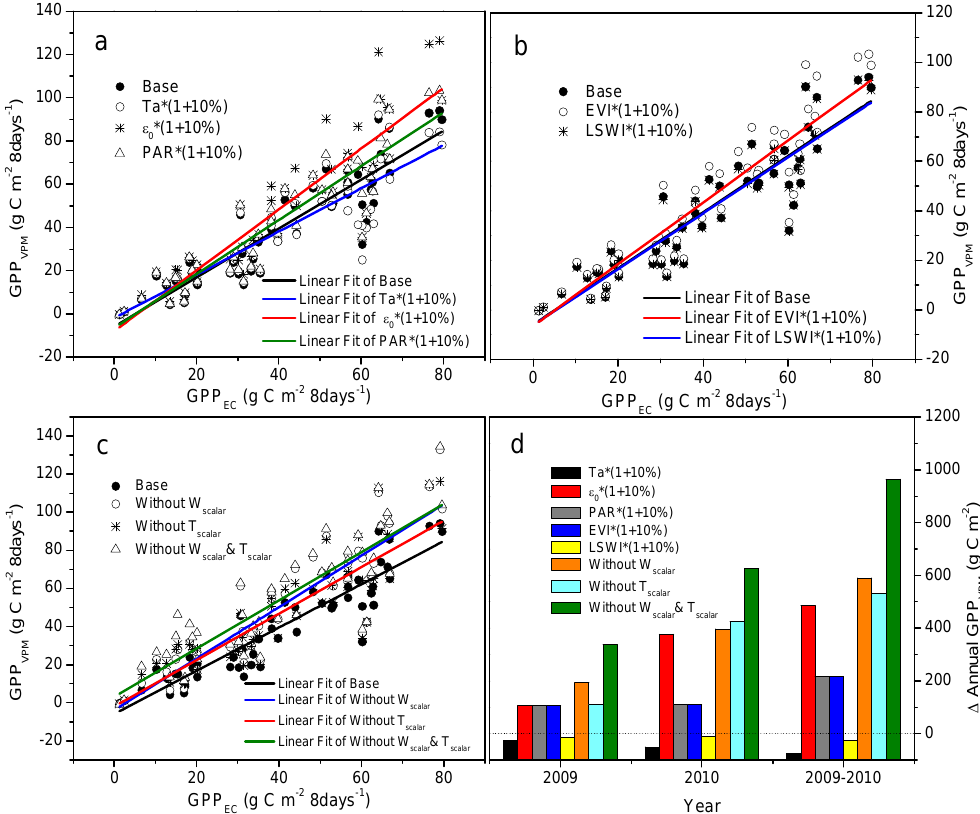
Figure 10. Parameter sensitivity analysis for VPM model in the targeted coastal wetland. GPP, gross primary production; GPP EC , estimated GPP from EC tower; GPP VPM , simulated GPP by VPM model; Ta, air temperature; ε 0 , maximum light use efficiency; PAR, photosynthetically active radiation; EVI, enhanced vegetation index; LSWI, land surface water index; W scala r and T scalar are the downregulation scalars for the impacts of water and temperature on light use efficiency, respectively. Base, all of the variables do not change, ε g = T scalar × W scala r × P scalar × ε 0 ; Ta · (1 + 10%), increase in Ta by 10%; ε 0 · (1 + 10%), increase in ε 0 by 10%; PAR · (1 + 10%), increase in PAR by 10%; EVI · (1+10%), increase in EVI by 10%; LSWI · (1 + 10%), increase in LSWI by 10%; Without T scalar , ε g = W scala r × P scalar × ε 0 ; Without W scalar , ε g = T scalar × P scalar × ε 0 ; and, Without T scalar & W scala r , ε g = P scalar × ε 0 .